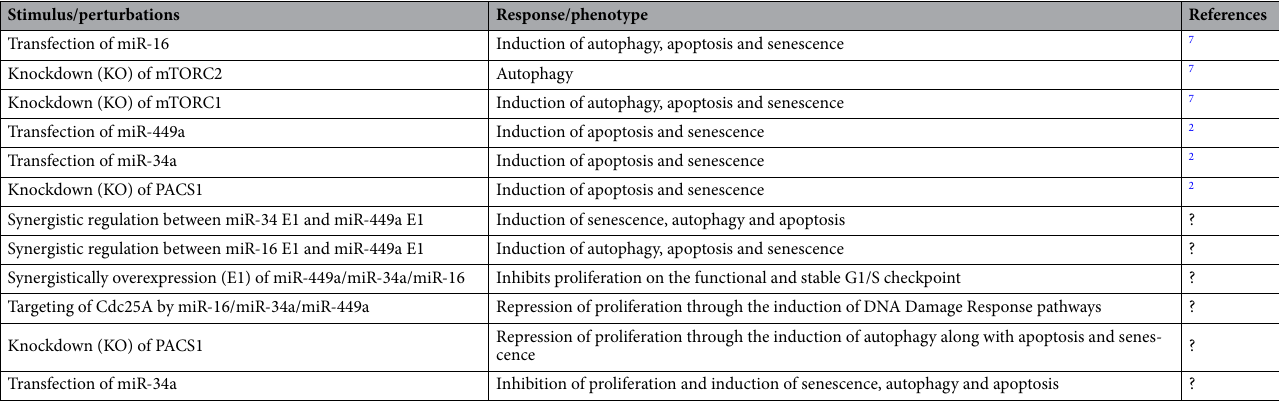
Table 1. Agreement between proposed Synthetic Boolean model and experimental data from the literature in HeLa cells. Ectopic expression (E1) represents gain of function (GoF) (or transfection of miRNA) and Knockdown (KO) represents loss of function (LoF) of the corresponding molecule. Cases for which no experimental data were found are indicated by